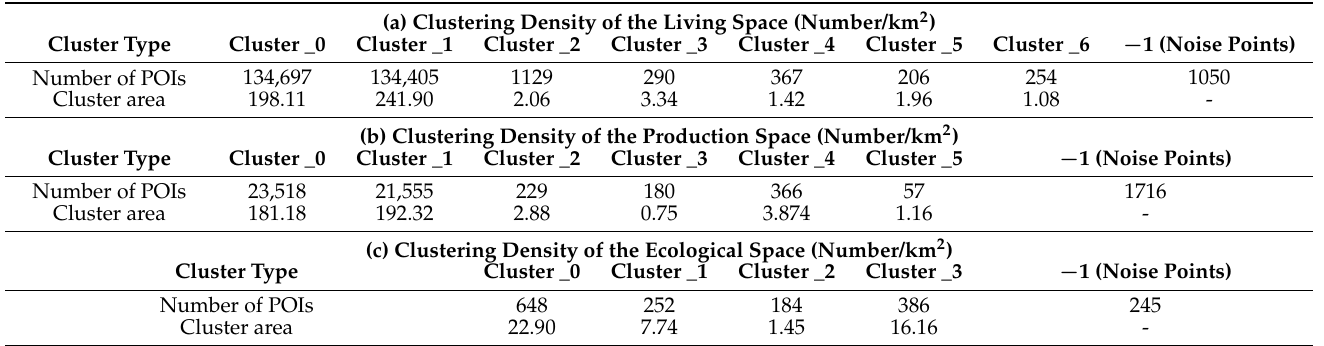
Table 3. Clustering density of the “production-living-ecological” space (Number/km 2 ). (a) Clustering Density of the Living Space (Number/km 2 ) Cluster